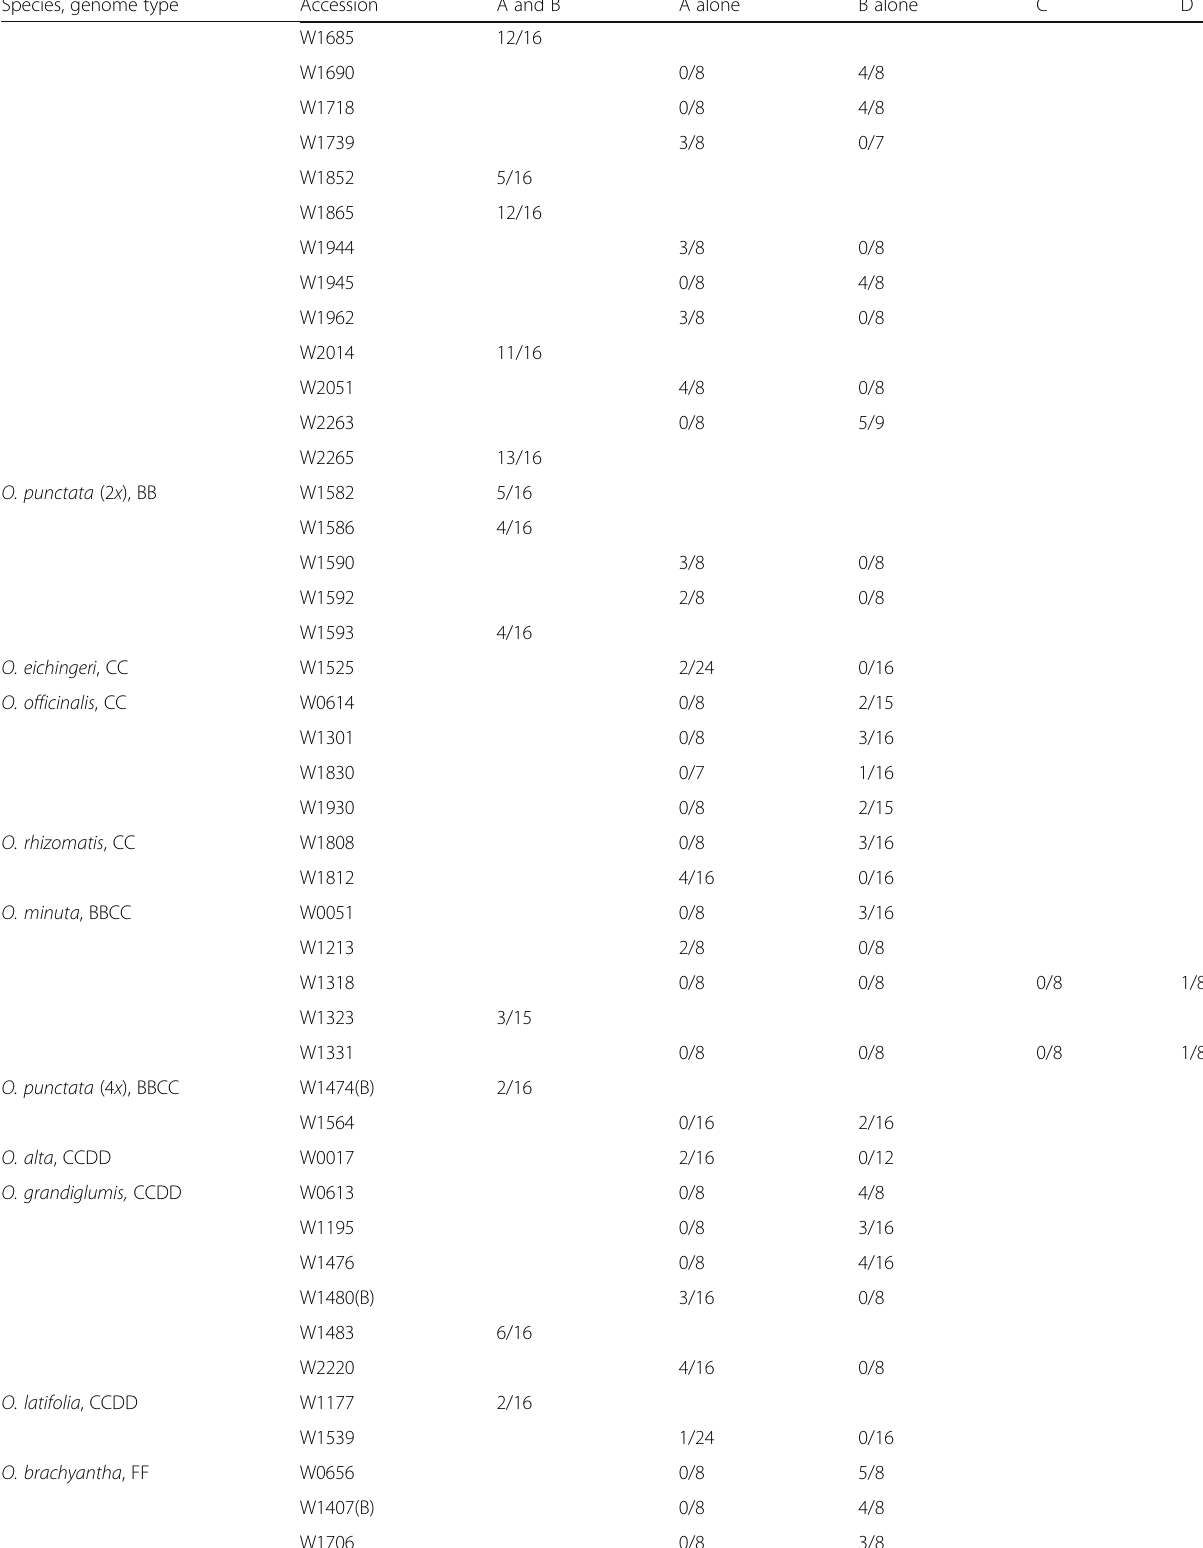
Table 2 Regeneration from immature embryos of wild Oryza accessions on 4 medium combinations (A – D) (Continued) Species, genome